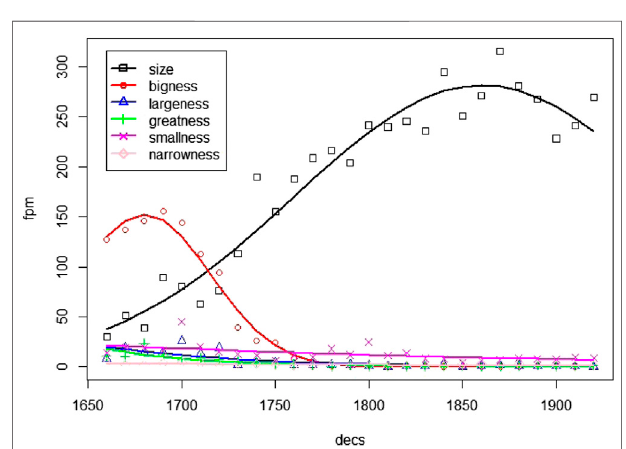
FIGURE 7 | Conventionalization by convergence on size